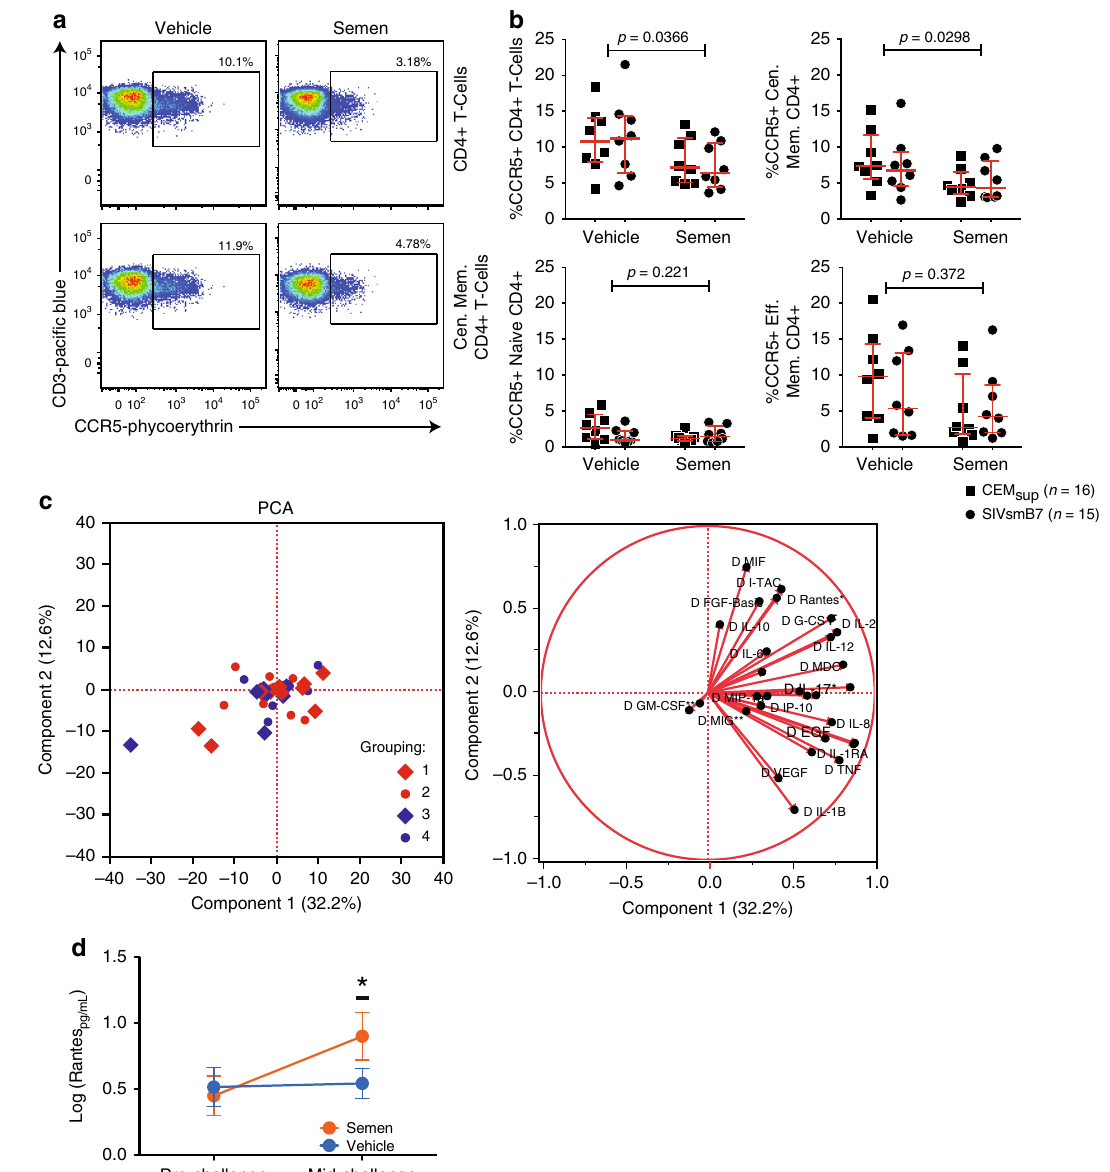
Fig. 2 Semen conditioning lowers CCR5 expression on peripheral CD4 + T-cells. a Representative fl ow cytometry plots of CCR5 expression on peripheral CD4 + T cells in semen verses vehicle-conditioned macaques. b CCR5 expression on peripheral CD4 + T-cells was signi fi cantly lower amongst semen- conditioned animals (Man – Whitney p = 0.0366) (top left). Reduced CCR5 surface expression was con fi ned to central memory CD4 + T-cells (Mann – Whitney p = 0.0298) (top right) as both naïve and effector memory CD4 + T-cells displayed no difference in CCR5 expression (bottom panels). c Principal Component Analysis (PCA) showed no segregation of animal groups based on vaginally secreted cytokines. d After the initiation of SIVmac251 low-dose challenge, semen-conditioned animals had an increase in RANTES. Error bars are represented as median with IQR. Source data are provided as a Source Data fi le